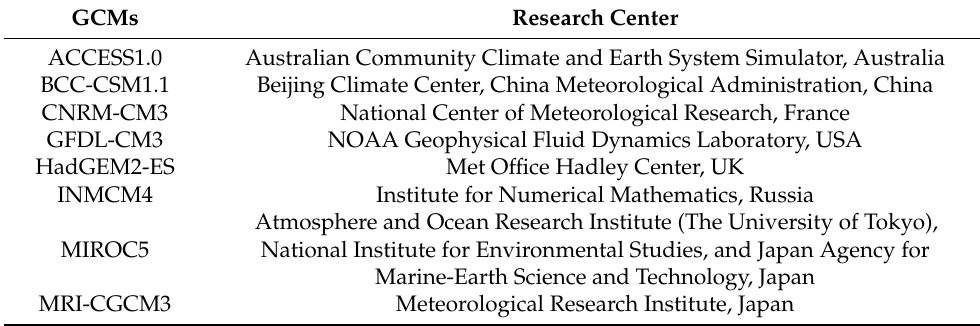
Table 4. Global Climate Models (GCMs) used to simulate the global wind-wave models available on CSIRO online database. GCMs